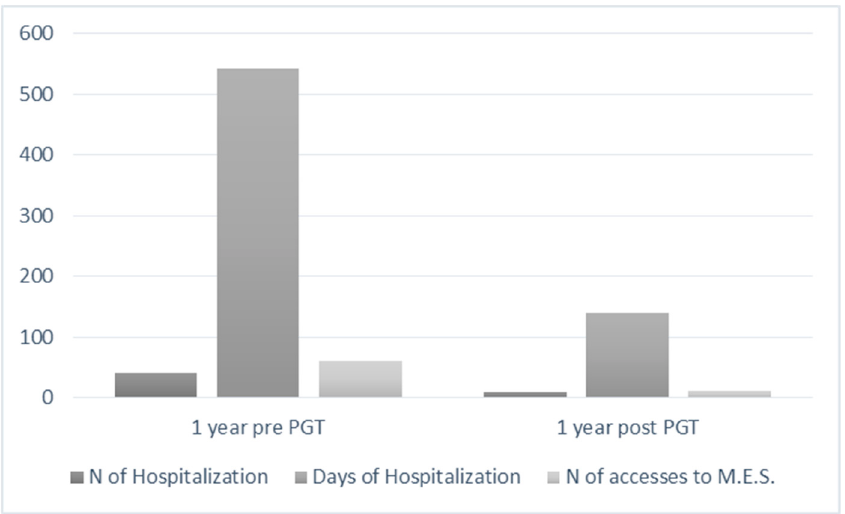
Figure 1. Mirror analysis of the number of hospitalizations, days of hospitalizations, and number of times medical emergency services were accessed.